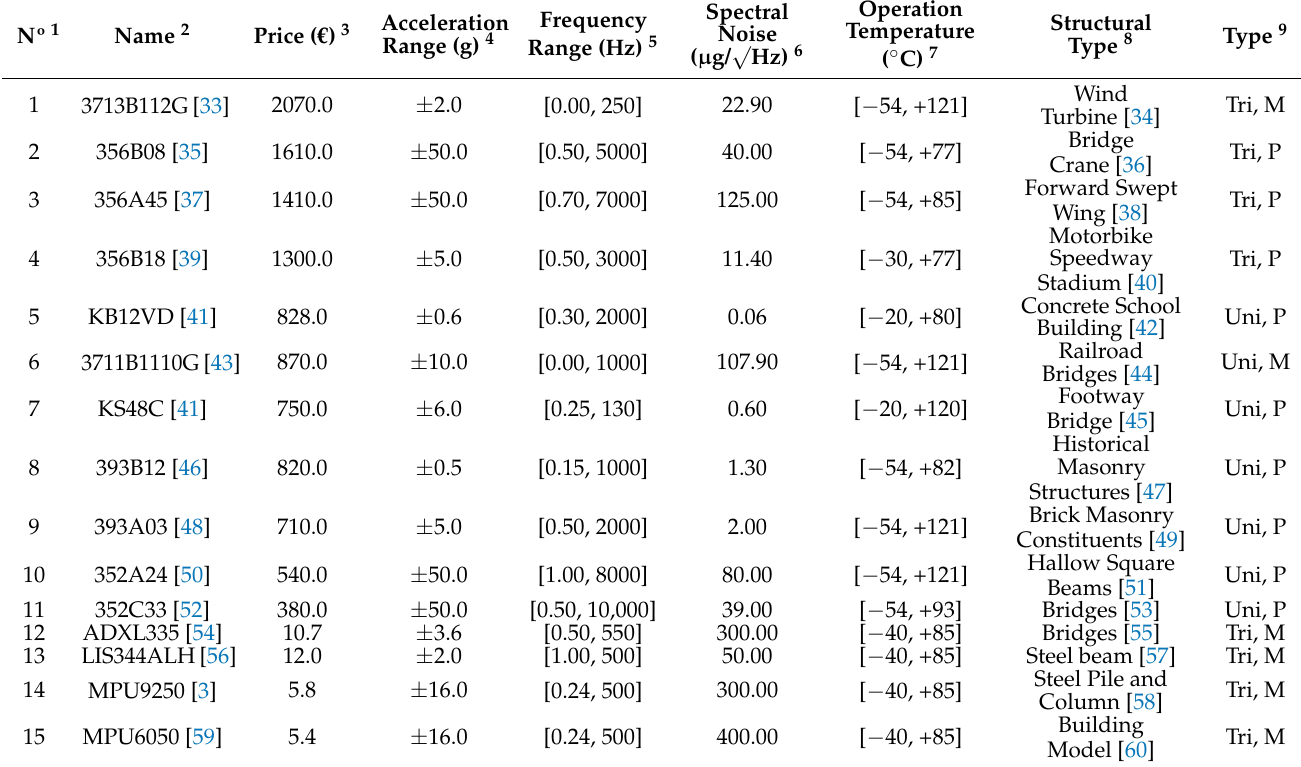
Table 1. Summary of the characteristics of the accelerometers commonly used in the